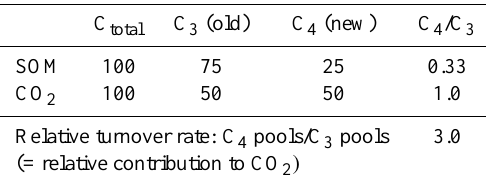
Table 2. Example of approach to evaluate contribution of two SOM pools to CO 2 fluxes ∗ based on relative turnover rates of old (C 3 ) and new (C 4 ) SOM pools after C 3 -C 4 vegetation change. All values are presented as percentage of total C in SOM or in CO 2 . (For experimental results based on this approach see Collins et al., 2000; Blagodatskaya et al.,